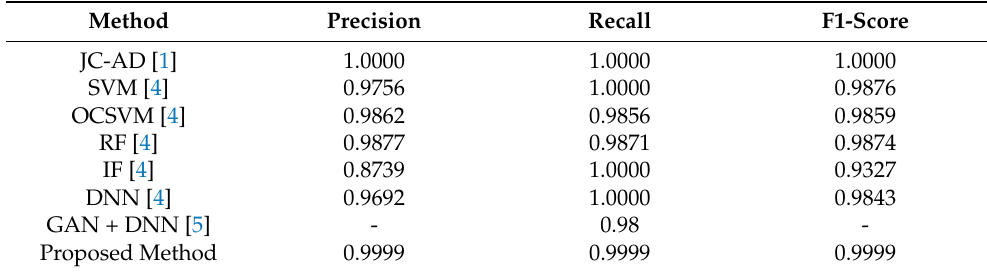
Table 4. Performance comparisons of the proposed method and related ICS anomaly detection methods for the binary-class (i.e., normal-anomalous)